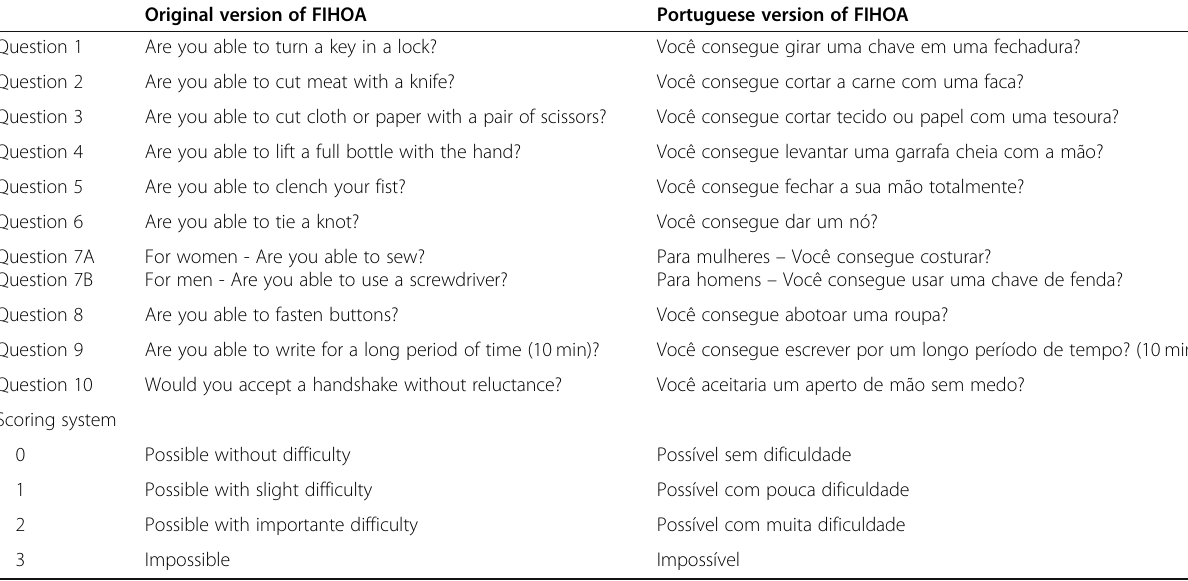
Table 1 Portuguese version of the Functional Index for Hand Osteoarthritis Original version of